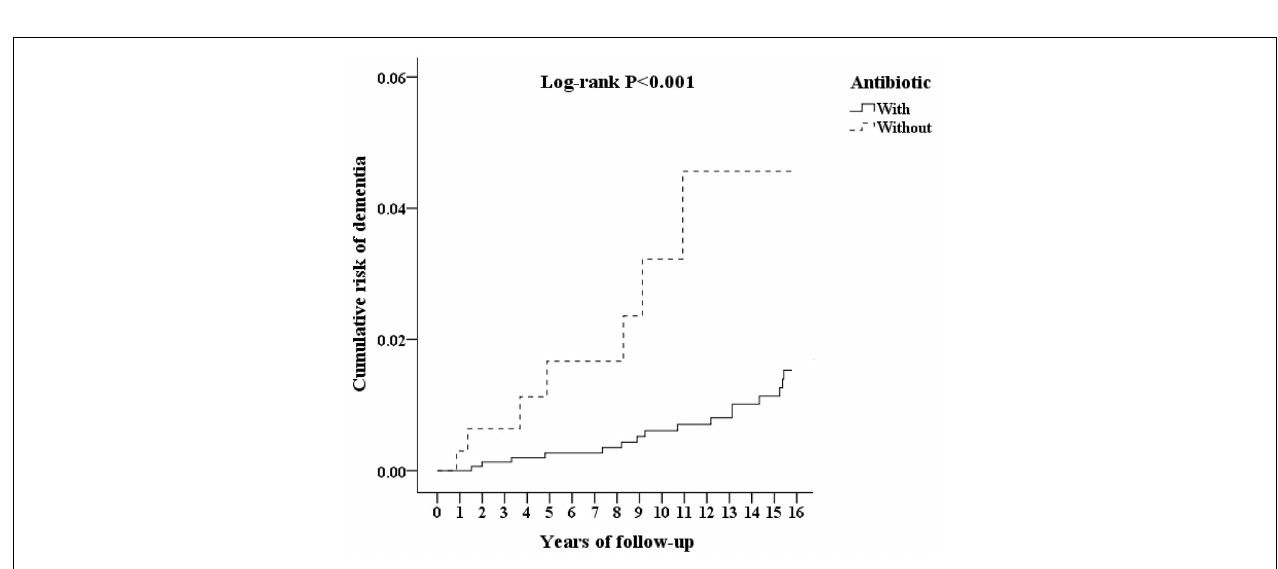
FIGURE 4 | Kaplan–Meier for cumulative incidence of dementia aged 50 and over stratified by Leptospirosis infections with or without antibiotics, with log-rank test.